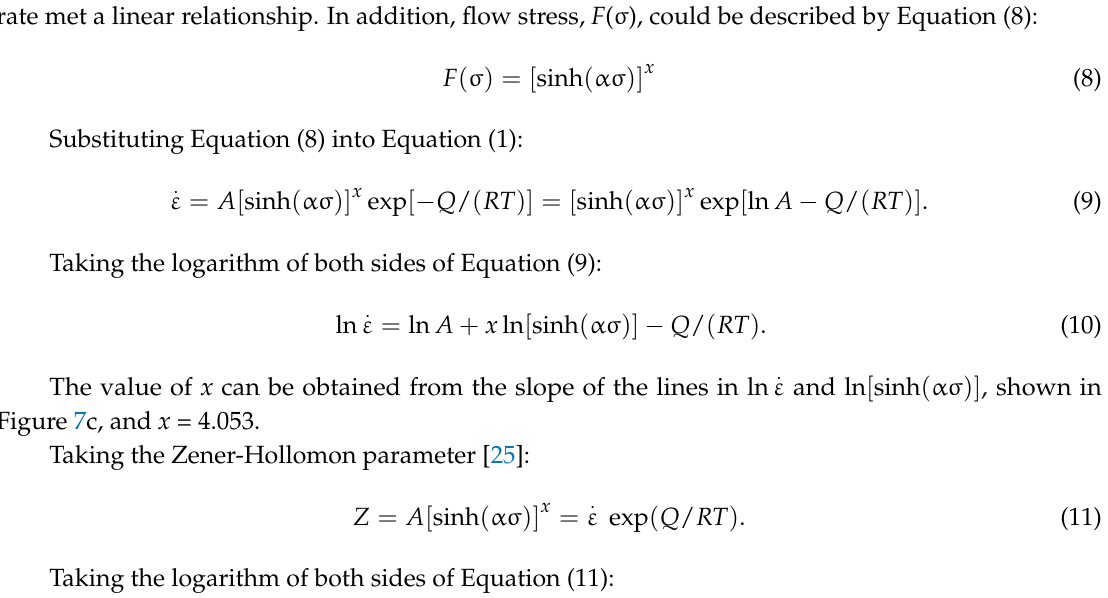
Figure 9. ln[sinh(ασ)]-1000 / T ( a ); ln -ln[sinh(ασ)] Z ( b ).